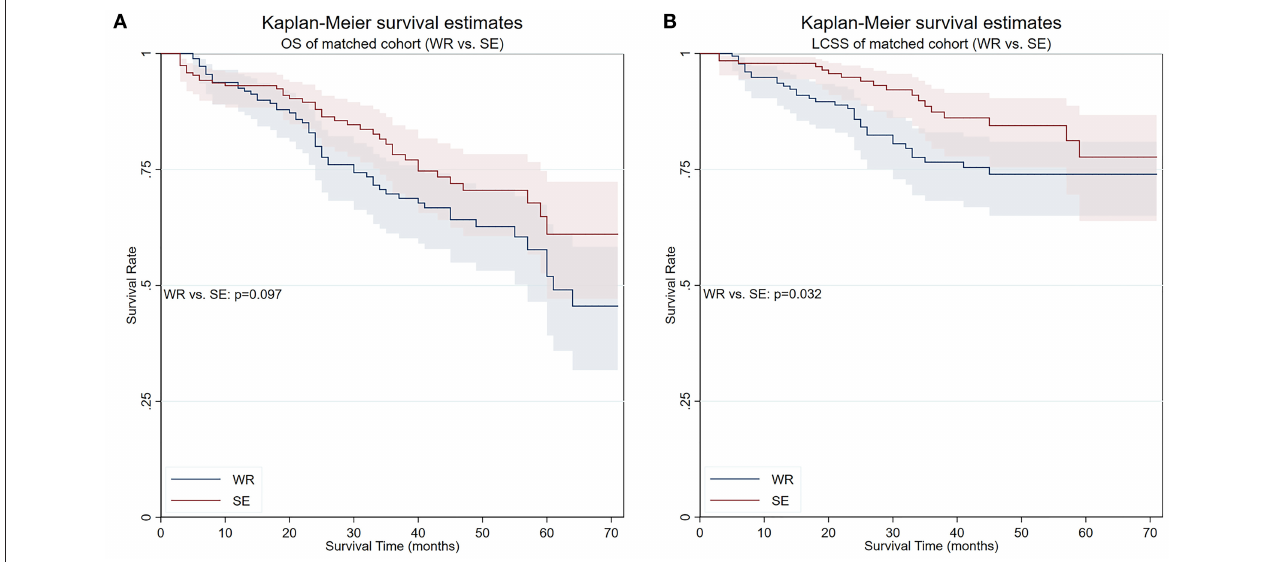
FIGURE 6 | OS and LCSS of PS-matched patients who underwent either wedge resection or segmentectomy. (A) OS of PS-matched patients who underwent either wedge resection or segmentectomy. (B) LCSS of PS-matched patients who underwent either wedge resection or segmentectomy. PS, propensity score; WR, wedge resection; SE, segmentectomy; LO,